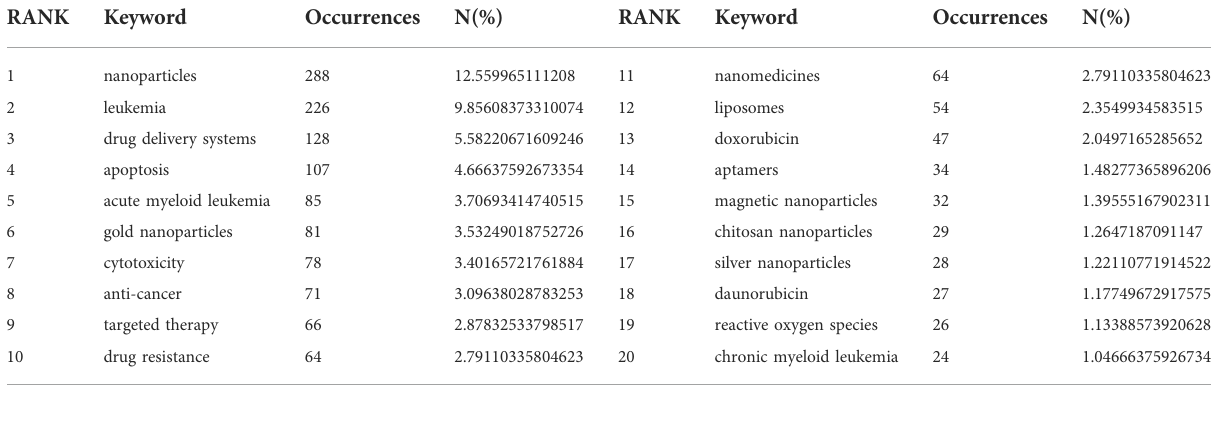
TABLE 5 The top 20 keywords of Nanoparticles-leukemia-related research.